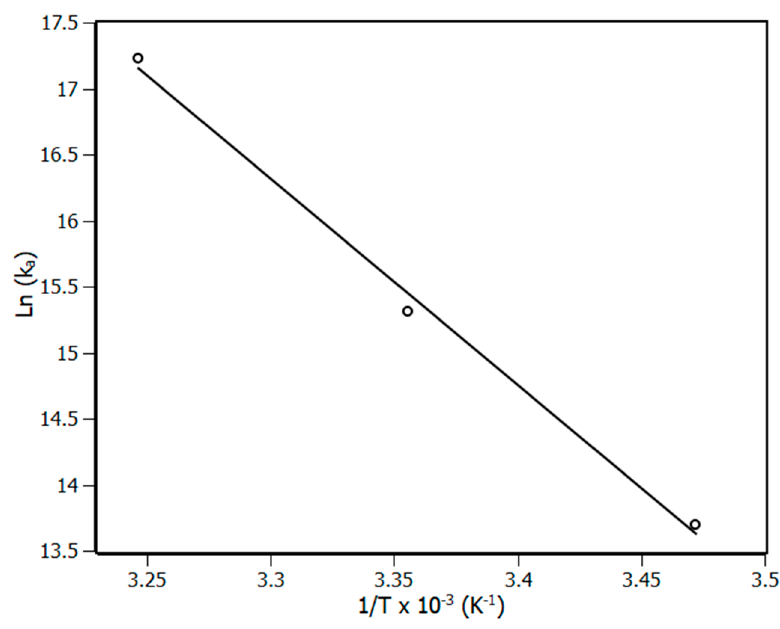
Figure 4. van’t Hoff plot for the complex NBD-piperine at 288 K, 298 K and 308 K. R 2 > 0.99. Figure 4. van’t Ho ff plot for the complex NBD-piperine at 288 K, 298 K and 308 K. R 2 >